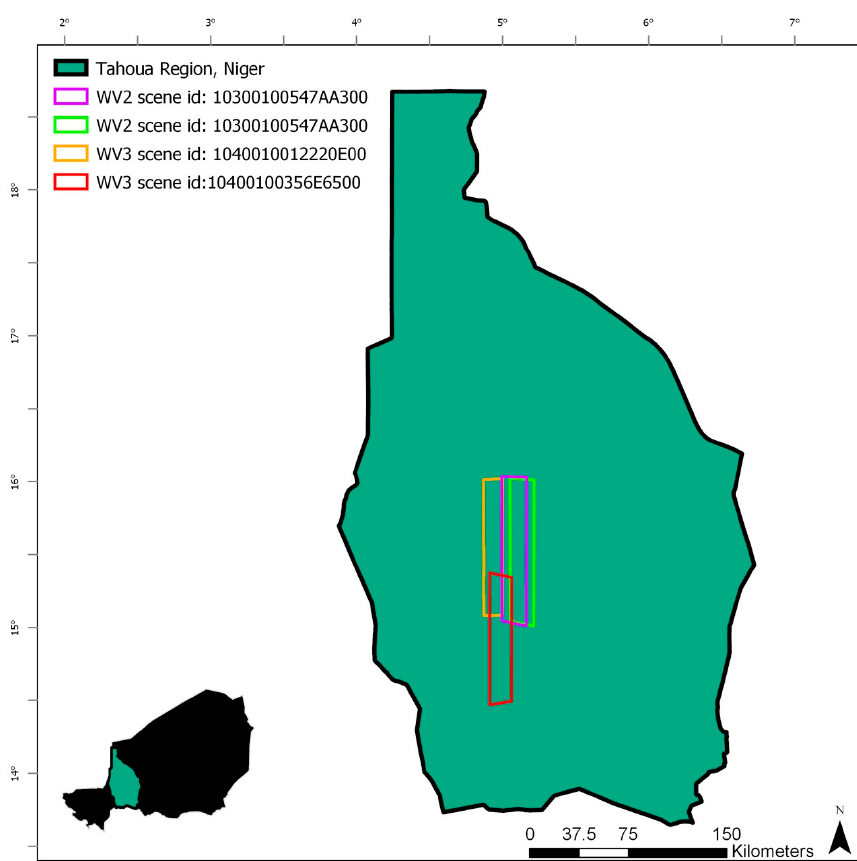
Figure 2. Study area (Tahoua Region) and DigitalGlobe WorldView imagery coverage.